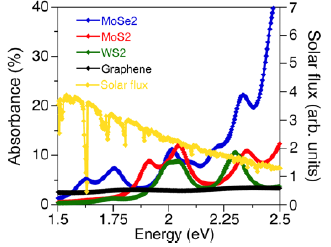
Figure 12. Bandgap absorbance of three TMD monolayers and graphene, overlapped to the incident AM1.5G solar flux. Reproduced with permission from [176], American Chemical Society, 2013.